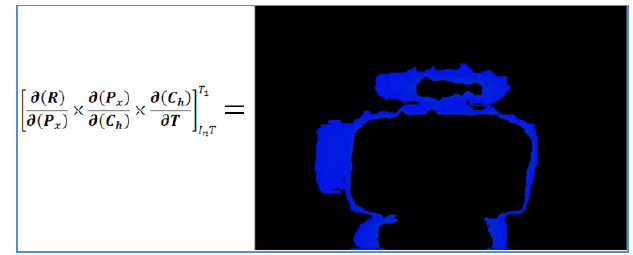
Figure 13. Chromatics value for Primary tolerance temperature level with canonical formation